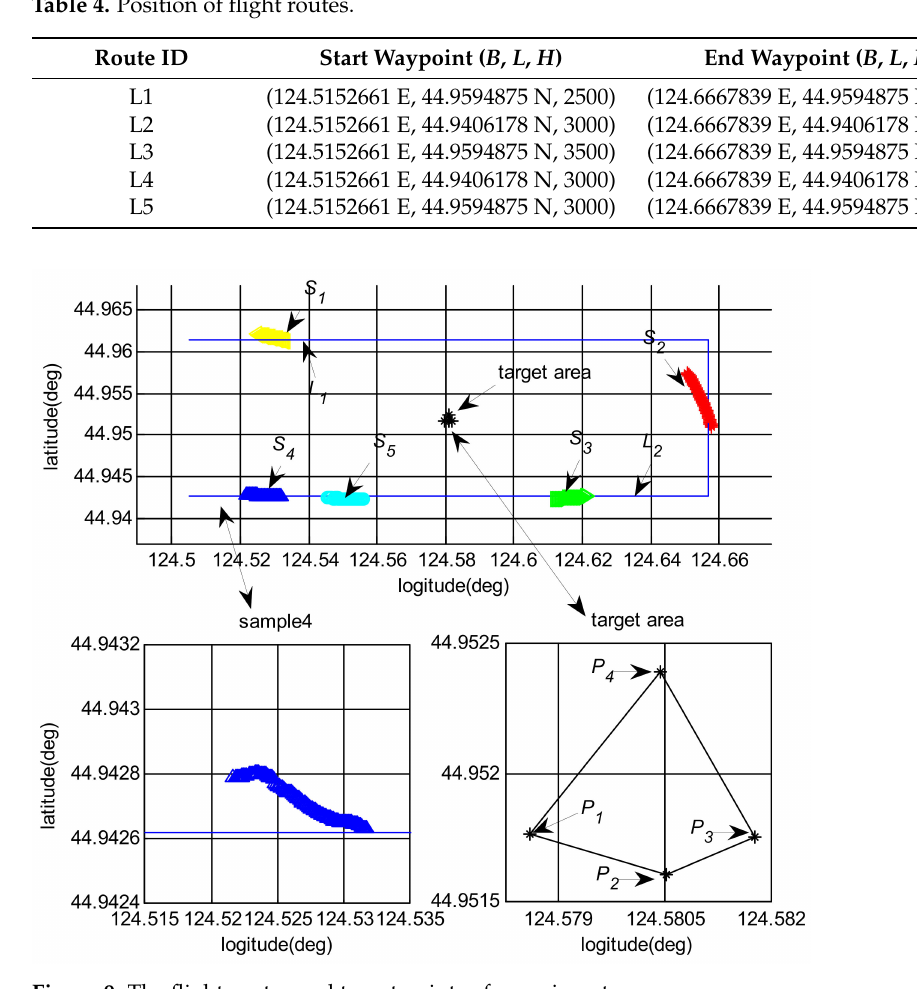
Figure 9. The flight routes and target points of